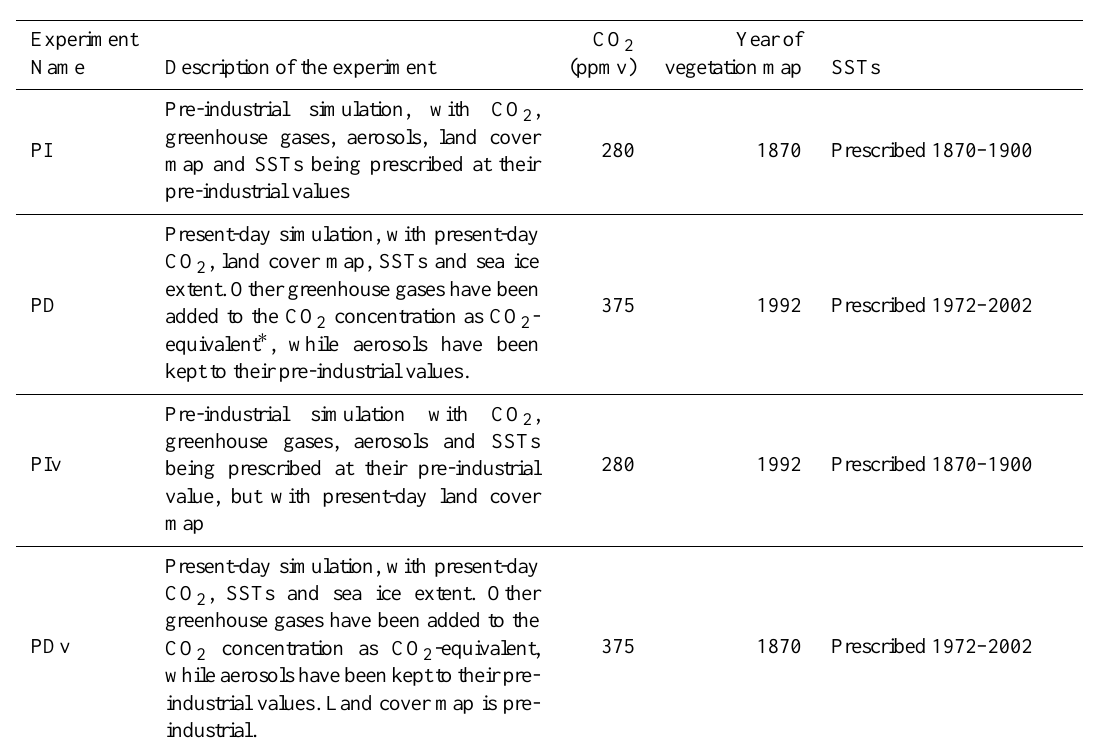
Table 2. Description of simulations performed by each climate